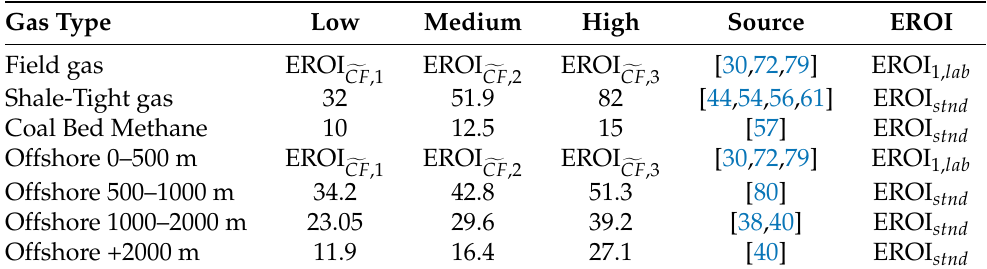
Table 4. EROI estimates (X:1) for each gas type. EROI model of Court and Fizaine [30]. The EROI nomenclature follows Murphy et al.